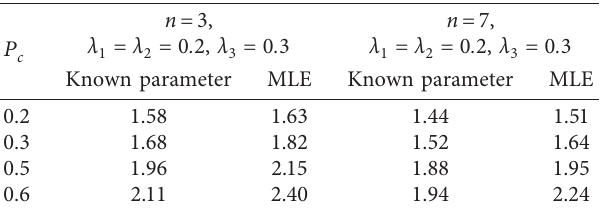
values ( β � 0 . CMHDEWMA